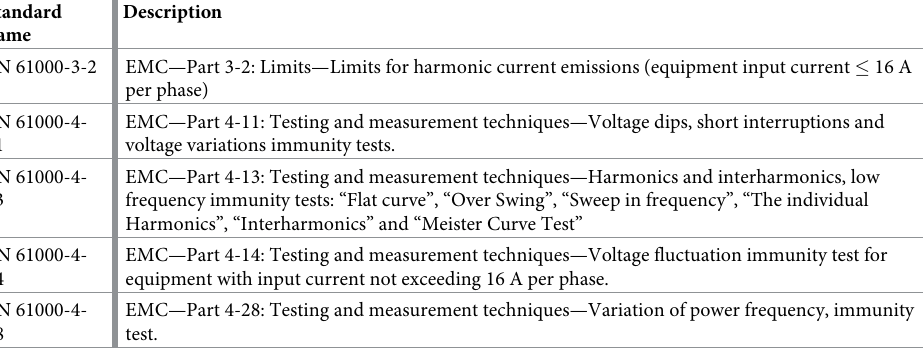
Table 2. Electromagnetic compatibility (EMC) tests performed on the protection